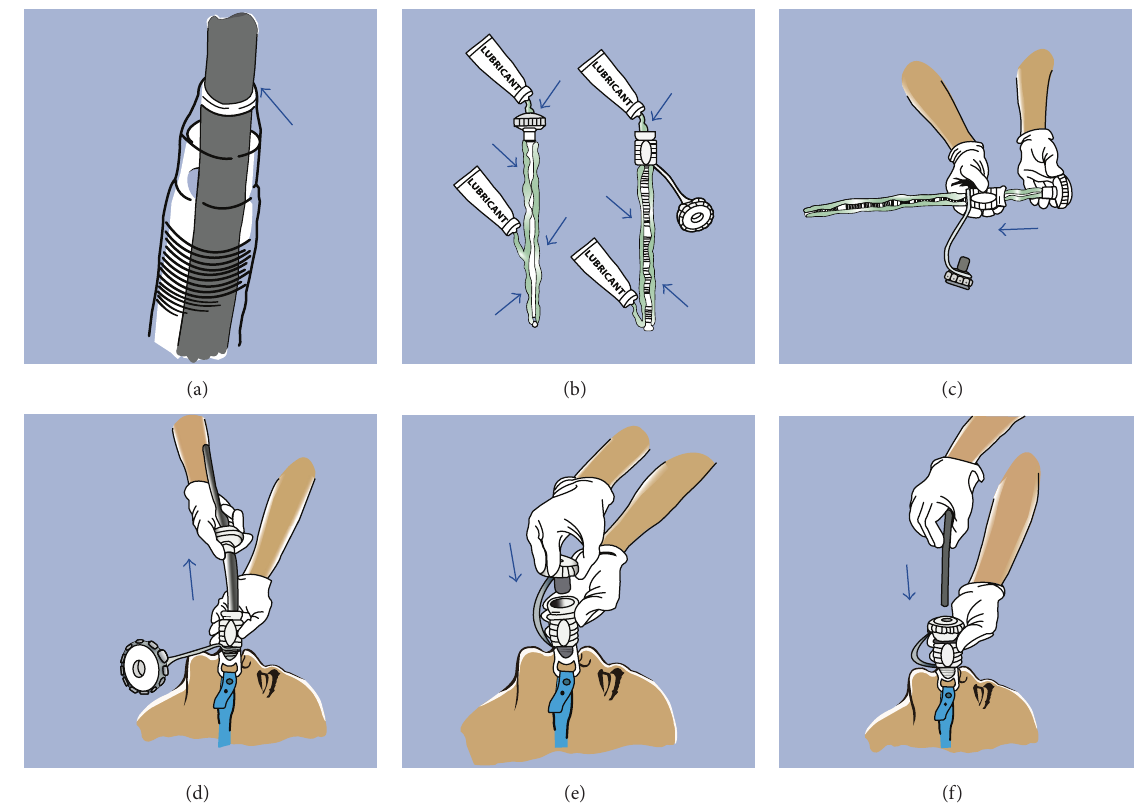
Figure 2: Step-by-step directions for positioning overtube. (a) Guardus overtube with correct snug fit of scope. (b) The inner and outer surfaces of both tubes are generously lubricated using a water-soluble lubricant (not water). (c) The fully lubricated inner tube is inserted into the fully lubricated outer tube and “backloaded” onto the scope, positioning the assembled Guardus overtube at the proximal end of the scope. (d) After performing baseline esophagoscopy, the overtube assembly is gently inserted into the esophagus through the bite block (use of a 60F bite block is recommended). The inner tube and scope are then simultaneously removed, leaving the outer tube in place. (e) The insufflation cap is attached. This minimizes backflow of bodily fluids and maintains insufflation throughout the procedure. (f) The scope is reintroduced through the insufflation cap into the stomach (courtesy of US Endoscopy, Mentor, OH). PEG placement then proceeds using the standard Guederer-Ponsky “pull” technique, with the catheter pulled through the outer overtube still maintained in the